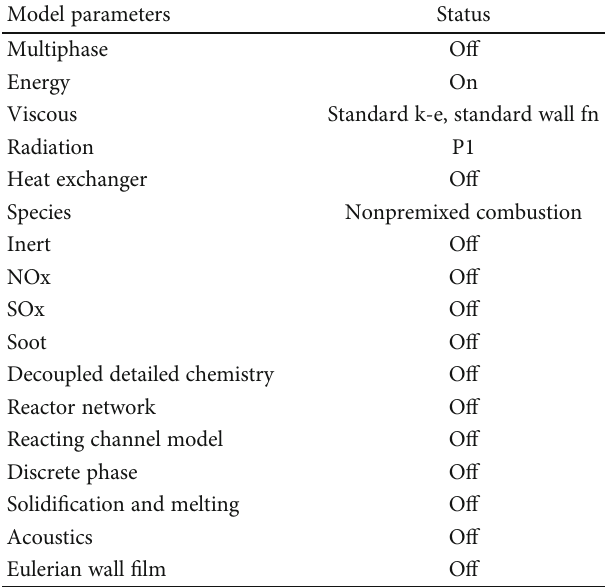
Figure 4: Burner mesh geometry generated using the ANSYS software. Table 1: Settings of the fl uent